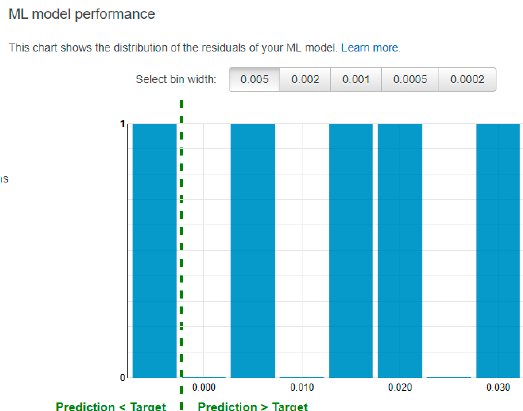
Figure 18. The AML model RMSE score.